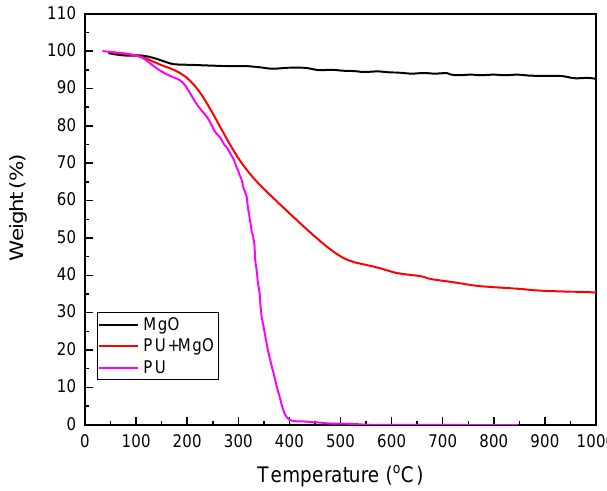
Figure 4. TGA curves of PU, MgO, and PU-MgO nanohybrids.